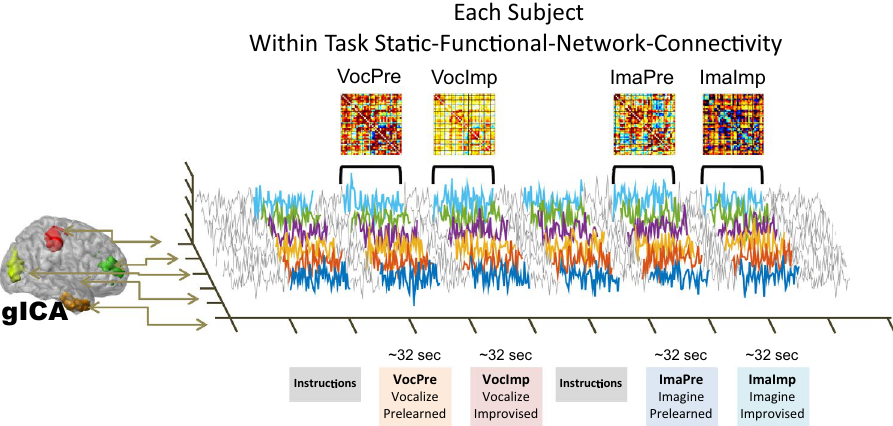
Figure 2. Task based static FNC procedure. Each subject went through four tasks on each session. The four tasks are: Vocalize Prelearned music (VocPre), Vocalize Improvised music (VocImp), Imagine performing Prelearned music (ImaPre), and Imagine performing Improvised music (ImaImp). Each task lasted an approximate of 32 s. Static FNC matrices were estimated using Pearson correlation coefficients applied for the duration of each